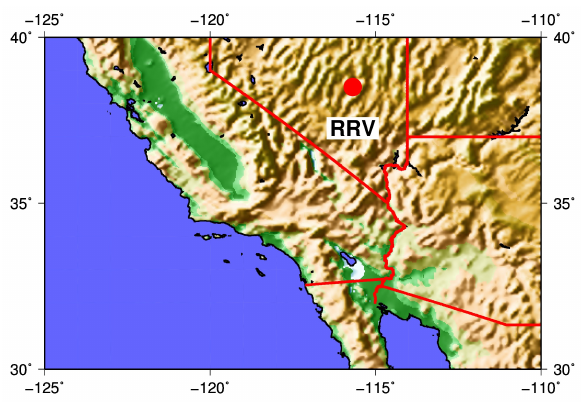
Figure 1. Location of Railroad Valley